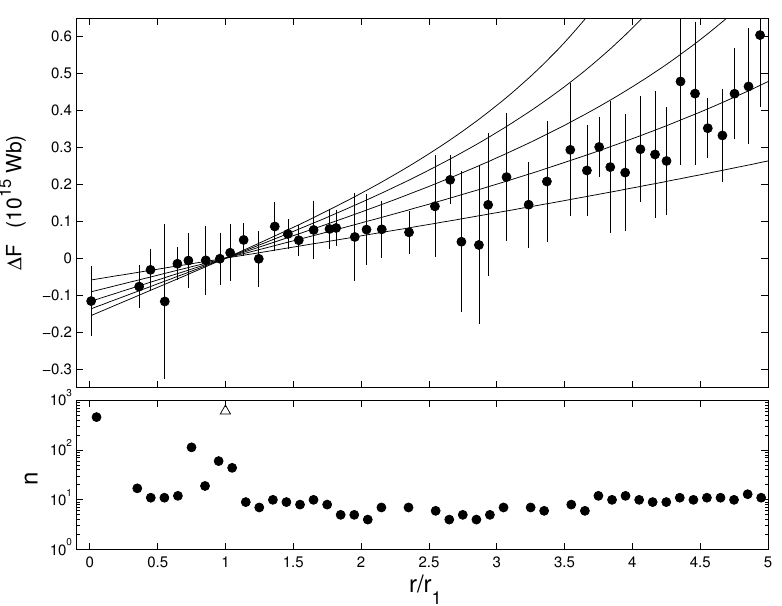
Figure 20: Top: The excess flux Δ 𝐹 from Equation (8) as a function of 𝑟/𝑟 1 . The data points show the mean values from the spacecraft data shown in Figure 18, averaged over bins in 𝑟 that are 0.1 AU wide, with error bars of plus and minus one standard deviation. The lines are the same as shown in Figure 18. The data point at the lowest 𝑟/𝑟 1 is the entire PFSS data set for the coronal source surface at 𝑟 = 2 . 5 𝑅 ⊙ . Bottom: The number of full Carrington rotation averages 𝑛 contributing to these means. The open triangle shows the number in the OMNI-2 data set from 𝑟 = 𝑟 1 . Note that 𝑛 is shown on a logarithmic scale. Image reproduced by permission from Lockwood et al. (2009c), copyright by